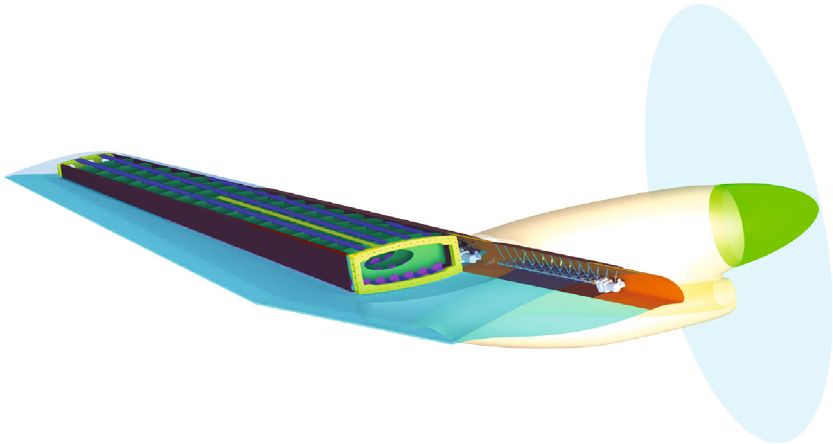
Figure 1: Twin prop regional aircraft equipped with the morphing droop nose.